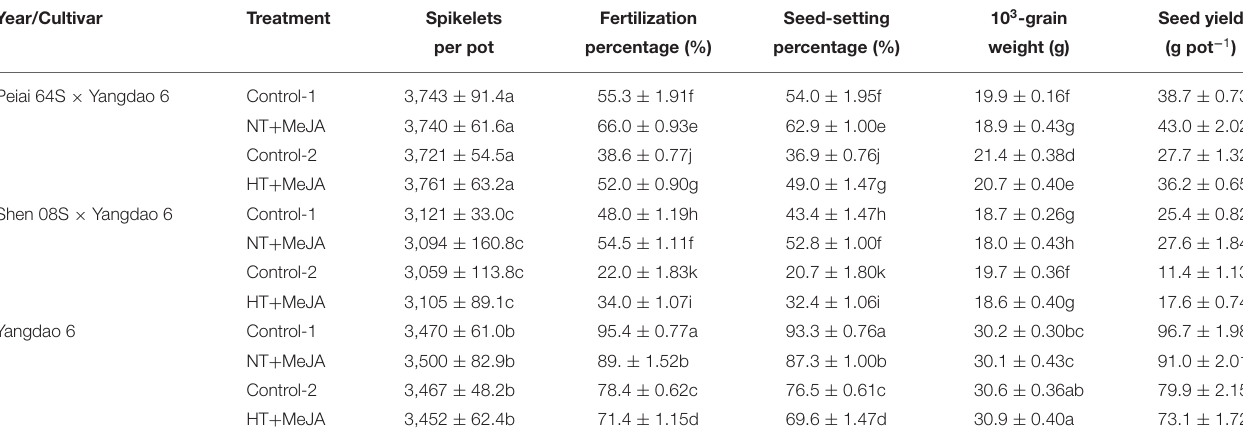
Control-1 and Control-2 indicate spraying water under normal temperature (NT) and spraying water under high temperature (HT), respectively. NT + MeJA and HT + MeJA represent spraying MeJA under NT and spraying MeJA under HT, respectively. Data are expressed as the mean ± SD (n = 5). Different letters indicate significant difference at the P ≤ 0.05 level within the same